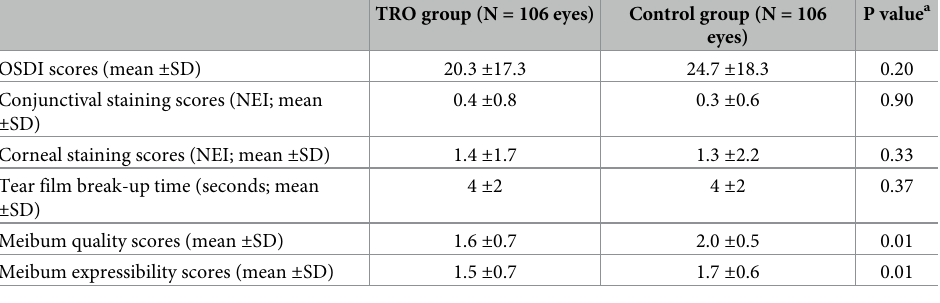
Table 2. Ocular surface symptoms and signs in thyroid related orbitopathy (TRO) and control